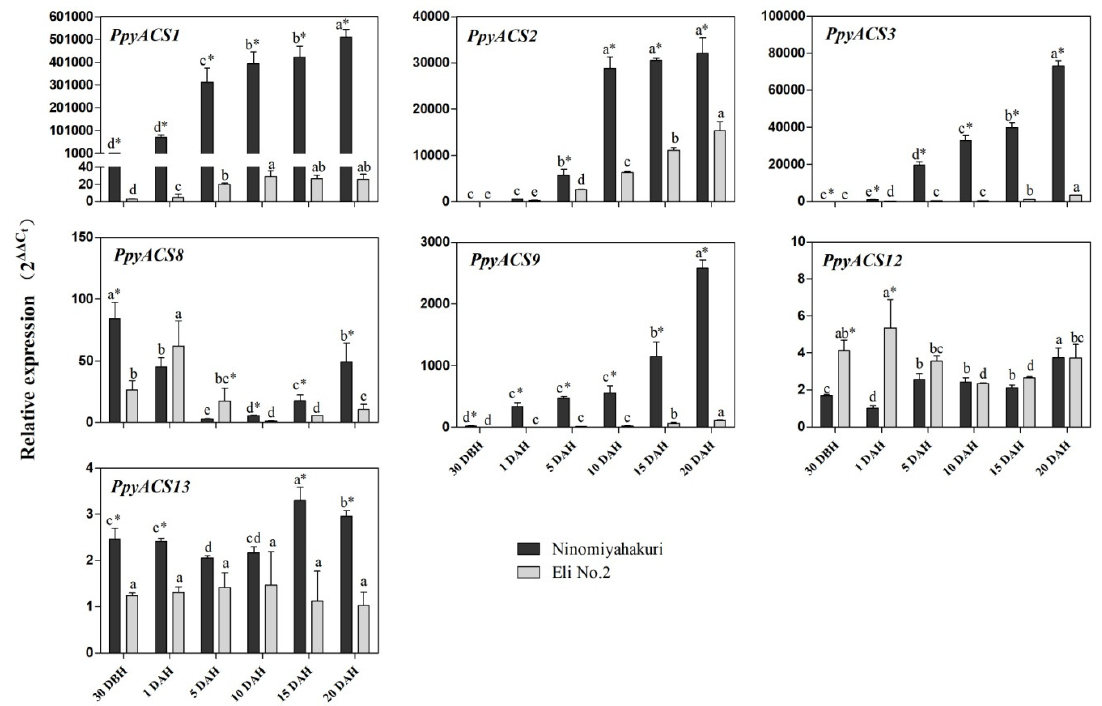
Figure 8. Comparison of PpyACS1 , PpyACS2 , PpyACS3 , PpyACS8 , PpyACS9 , PpyACS12 and PpyACS13 expression levels between ‘Ninomiyahakuri’ and ‘Eli No.2’ fruitsat different ripening stages. DBH: day before harvest. DAH: day after har- vest. ‘*’Each graph indicates a significant difference between ‘Ninomiyahakuri’ and ‘Eli No. 2’ cultivar ( t -test, n = 3, p < 0.05). Different lower-case letters indicate significant differencesbetween time points in the same cultivar (Duncan-test, n = 3, p < 0.05).